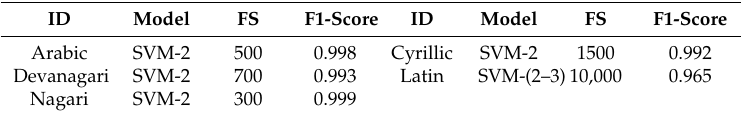
Table 14. Optimal classification method (OCM) for LI in different scripts in two-stage LI.